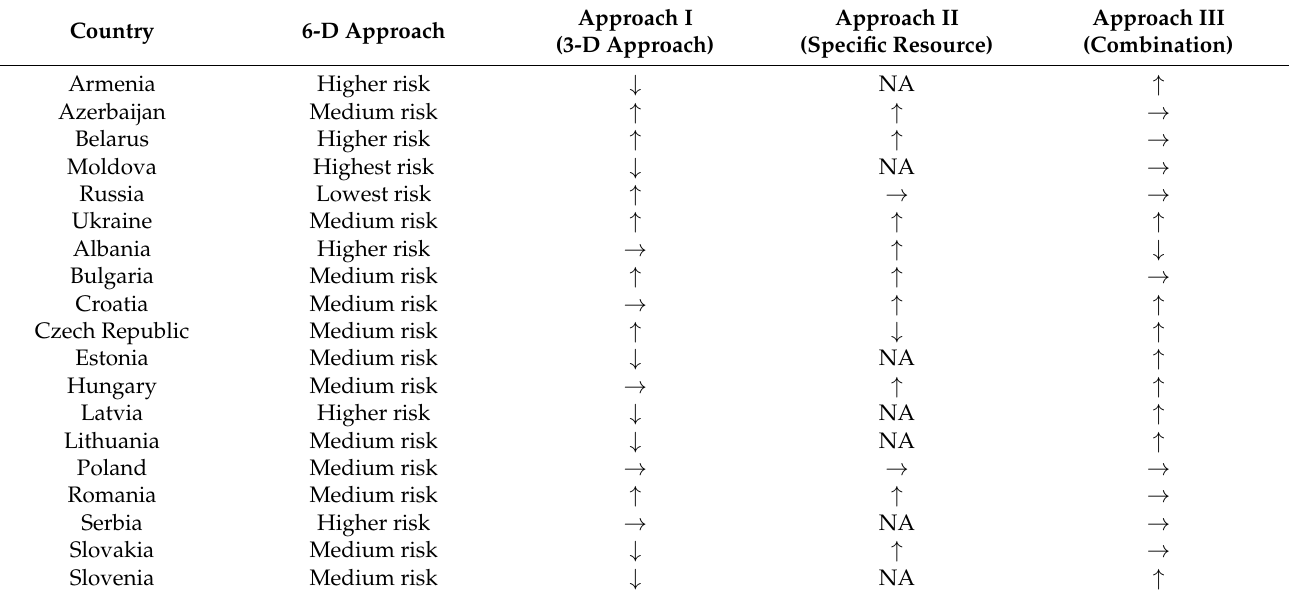
Table 8. Comparison of risk assessment results in Central and Eastern Europe and Russia and